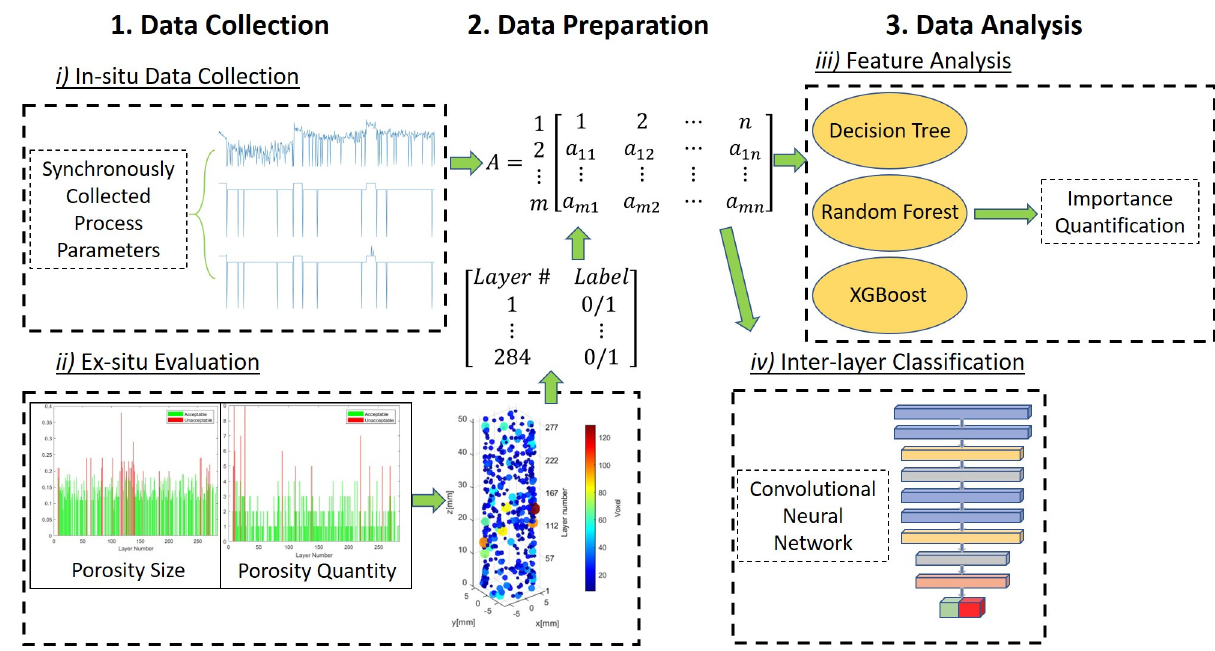
Figure 3. Design